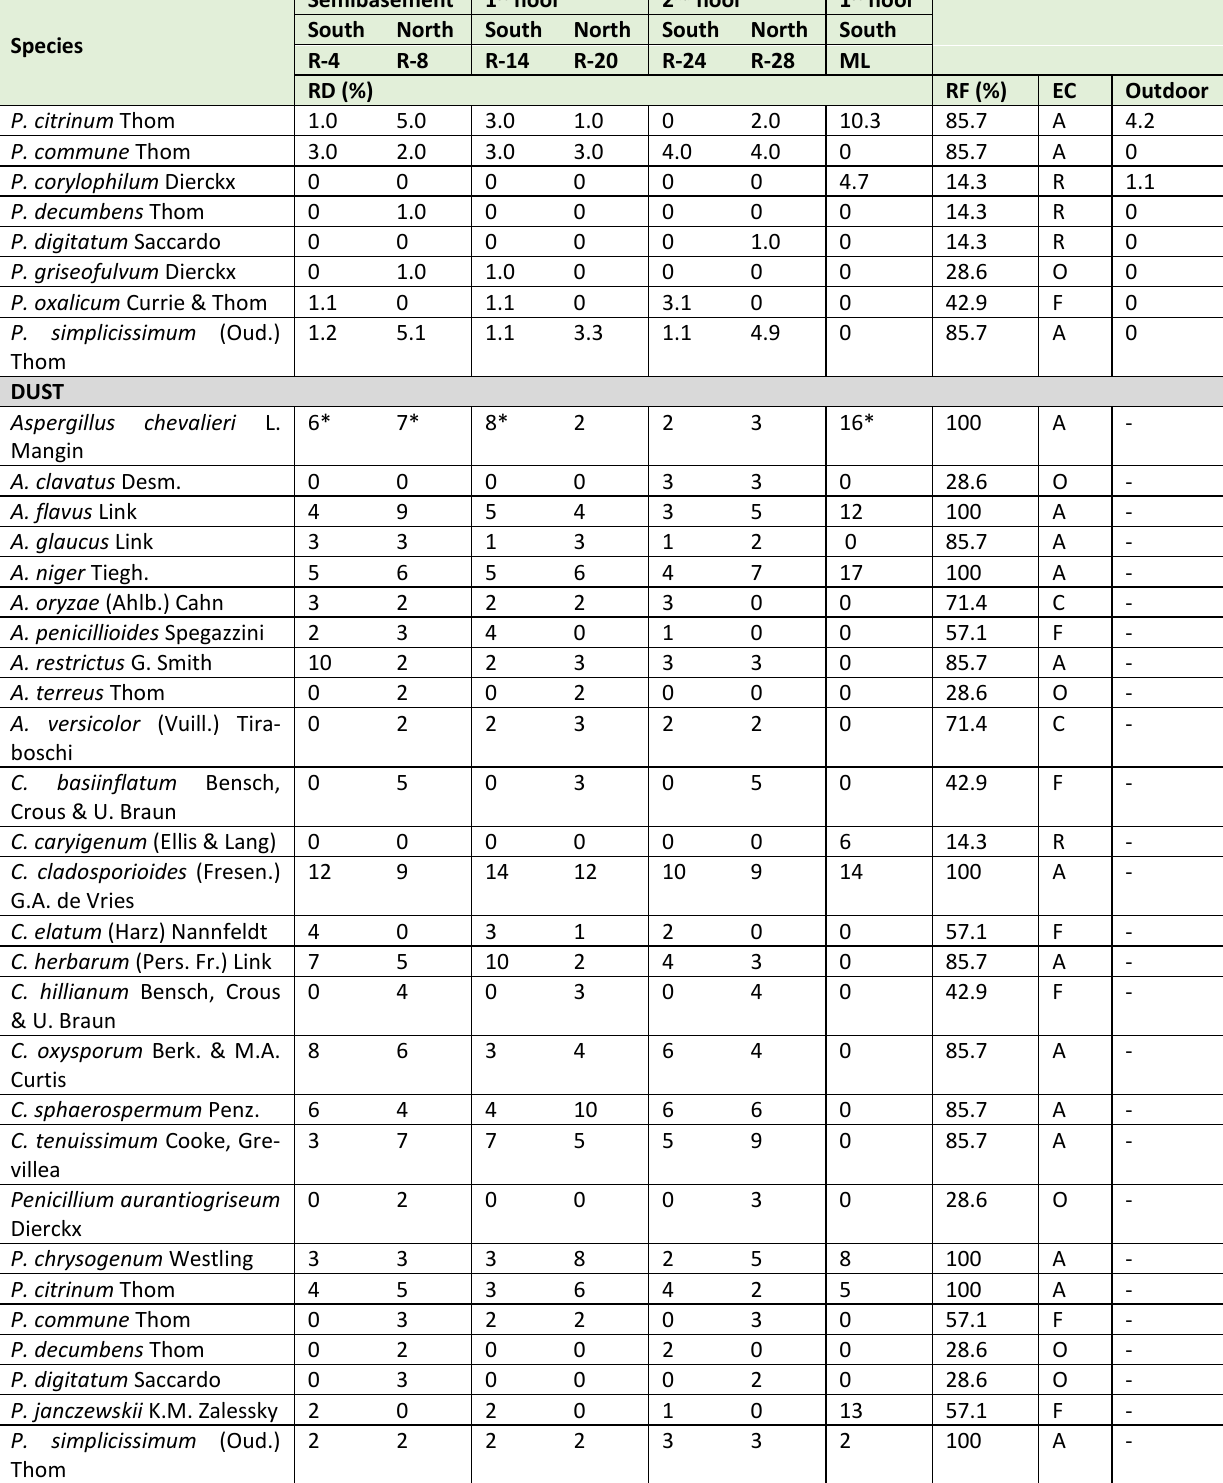
RF: Relative frequency. EC: Ecological categories [30] are Abundant taxa (A) when RF = 100 - 81%, Common taxa (C) when RF = 80 - 61%, Frequent taxa (F) when RF = 60 - 41%, Occasional taxa (O) when RF = 40 - 21% and Rare taxa (R) when RF = 20 - 0.1%. *: Indicates the ex- istence of different percentages of teleomorphs